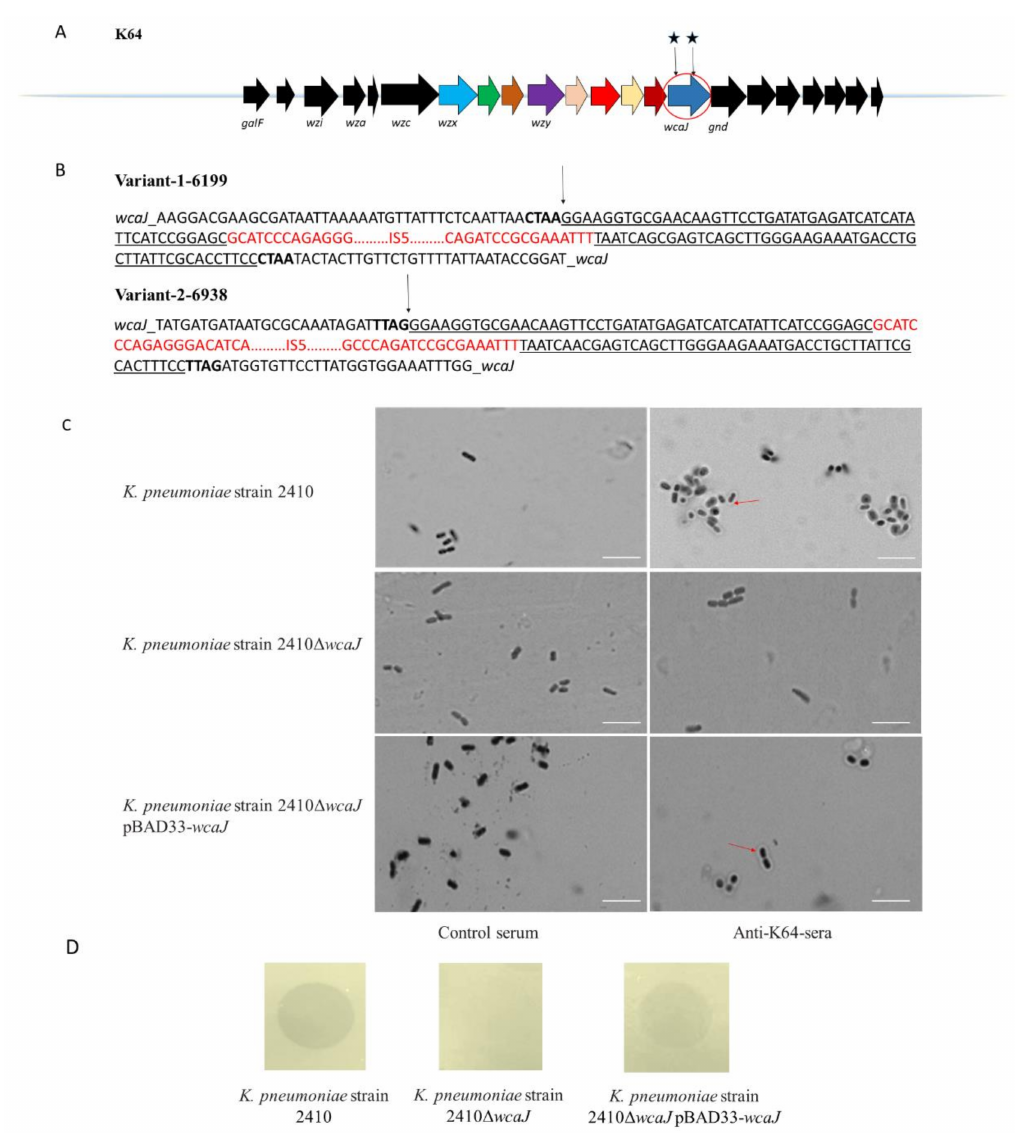
Figure 4. cps -locus variants in K pneumoniae clinical isolates and Quellung reaction and spot-assay test of the wcaJ mutant strains. ( A ) Schematic representation of the cps gene clusters in K. pneumoniae strain 6199. Open reading frames (ORFs) were shown as arrows and conserved genes were shown in black. Other gene contents were marked in different colors. The gene with insertion sequence (IS) insertions were circled in red. Blue pentacle indicated an IS 5 insertion containing variant. ( B ) Nucleotide sequence for IS Kpn26 insertions disrupting the wcaJ open reading frame within the cps gene clusters in K. pneumoniae strain 6483 and 6938. Small black arrows indicated the beginning of the IS 5 sequence. Direct repeats generated by IS 5 were represented in bold. IS 5 imperfect inverted repeats were shown by underlined and IS 5 coding region were shown in red. ( C ) Quellung reaction of K. pneumoniae strain 2410, K. pneumoniae strain 2410 ∆ wcaJ , K. pneumoniae strain 2410 ∆ wcaJ -pBAD33- wcaJ , K. pneumoniae strain 6199-pBAD33- wcaJ, and K. pneumoniae strain 6821-pBAD33- wcaJ . Strains were incubated with K64-antisera or control-serum. The wcaJ mutant did not show the capsular swelling under the light microscope and the result was reversed upon complementation. Scale bar, 1 µ m. ( D ) Spot tests of K. pneumoniae strain 2410, K. pneumoniae strain 2410 ∆ wcaJ and K. pneumoniae strain 2410 ∆ wcaJ -pBAD33- wcaJ. K64-ORF41 were spotted on the bacterial lawns. SUMO was used as a negative